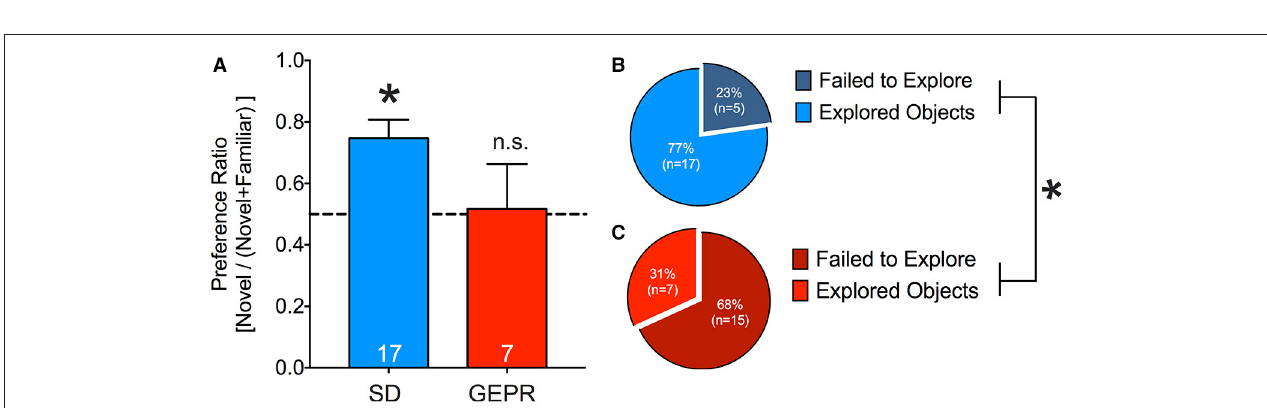
FIGURE 8 | Novel object recognition test. (A) SD rats showed the expected novel object preference during the retention probe conducted 2 h after the familiarization session (one sample t -test, t = 4.1, df = 17, * P = 0.0008), GEPR-3s did not (preference ratio did not differ significantly from chance, P = 0.9). Preference ratio trended toward but did not reach the level of statistical significance between these two groups ( t = 1.7, df = 23, P = 0.09). (B,C) Proportion of animals that failed to explore the objects during the familiarization session; A greater proportion of GEPR-3s failed to explore the objects as compared to SD rats (* P = 0.006, Fisher’s Exact Test). Figures show mean and standard error of the